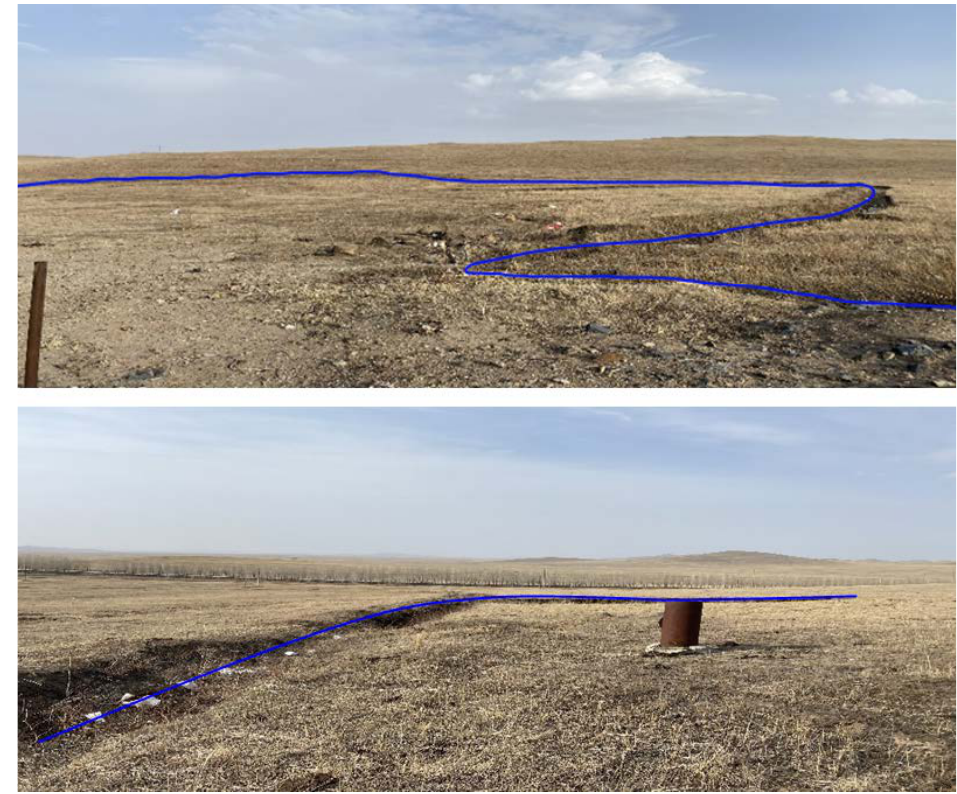
Figure 10. Status of the Alhada surface-collapse